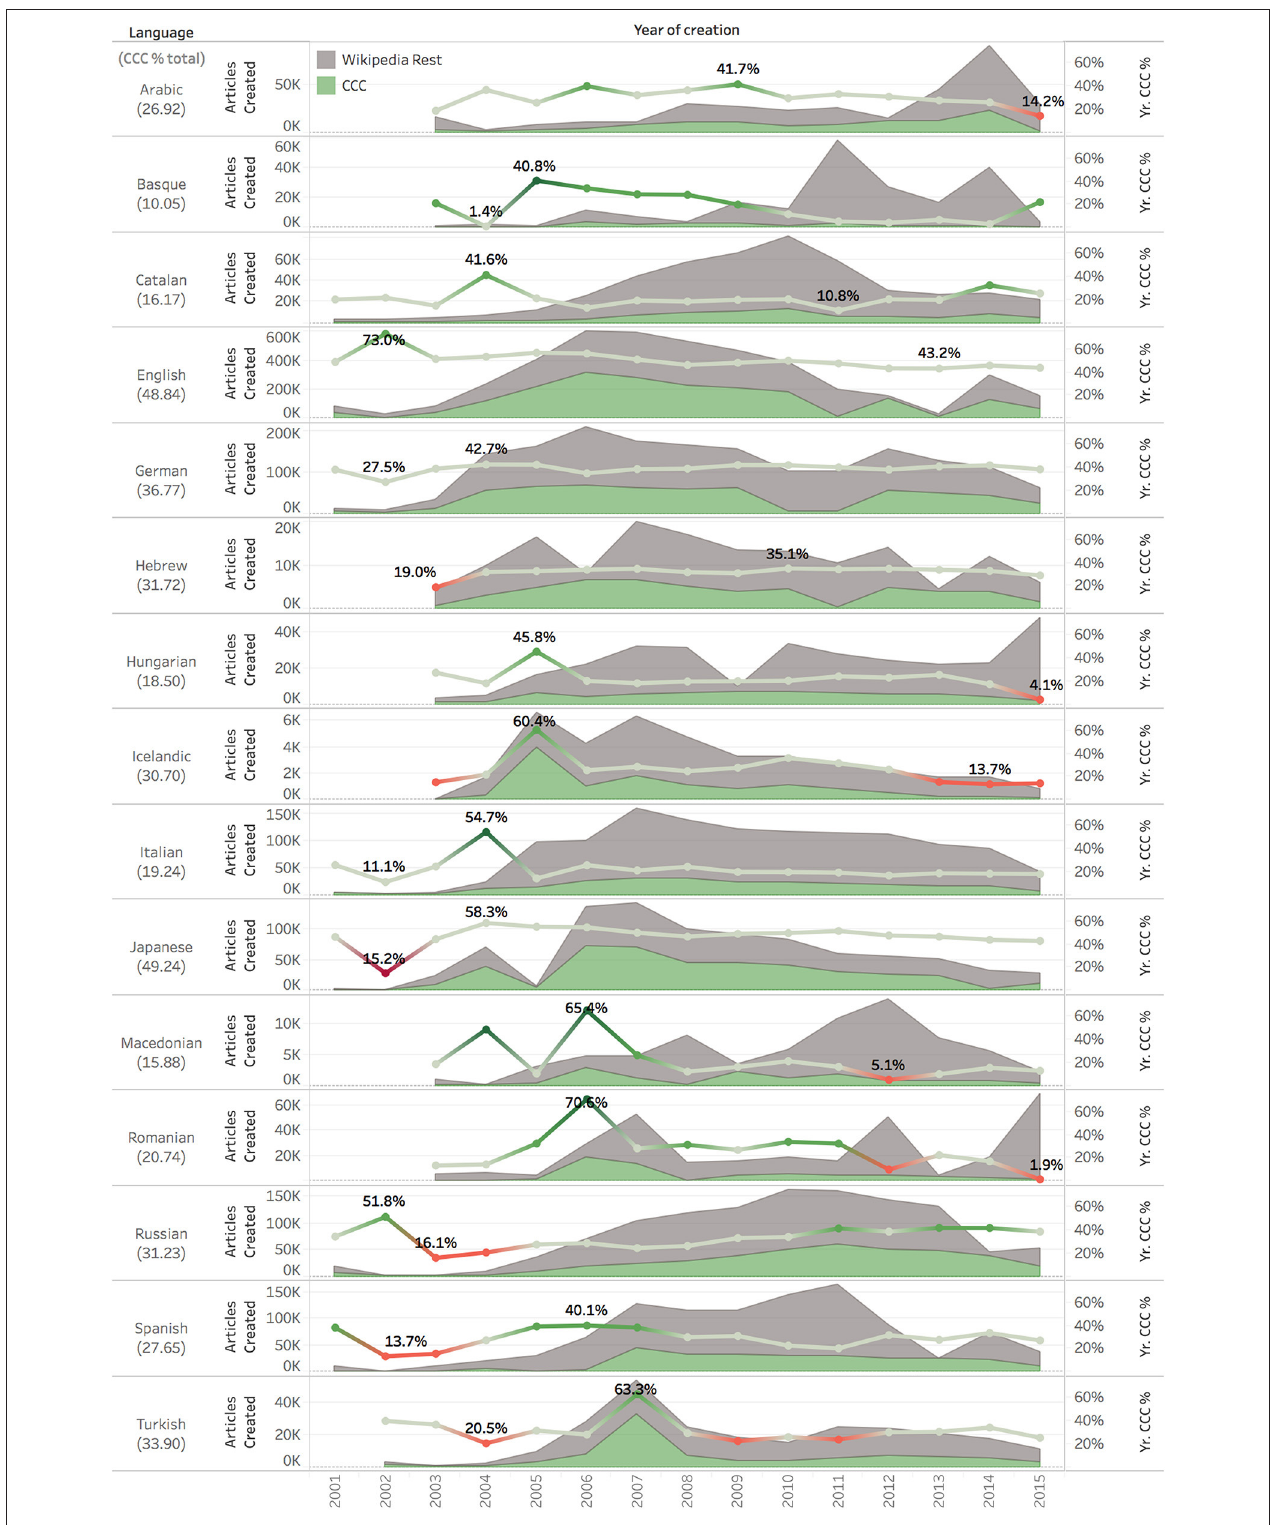
FIGURE 4 | CCC creation over the 15 years of Wikipedia. For each language edition, the green area represents the absolute number of CCC articles created over years, and the gray area the rest of the articles created. The line shows the percentage of CCC over the total number of articles created during each year; it is depicted in gray when it is in line ( < 10% variation) with the final overall percentage of CCC in the encyclopedia, in green or red when it is higher or lower.